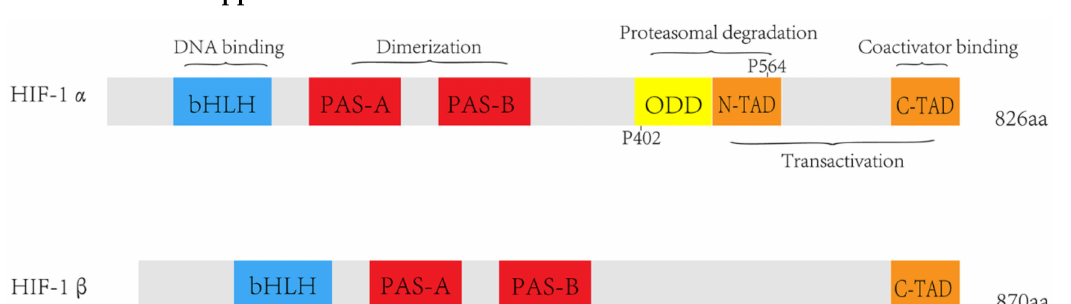
Figure A1. HIF-1 is a heterodimeric complex consisting of an HIF-1 α subunit and an HIF-1 β subunit. HIF-1 α contains multiple functional structural domains, including the bHLH structural domain, the PAS structural domain, the ODD structural domain, and the TAD structural domain. The bHLH and PAS domains are involved in dimerization and DNA binding, while the ODD domain is mainly involved in the proteasomal degradation of HIF-1 α under normoxic conditions, and the TAD domain is involved in the regulation of target genes by HIF-1 α . Abbreviations: bHLH: basic helix − loop − helix; PAS: Per-ARNT-Sim; TAD: trans-activation structural domain; ODD: oxygen-dependent degradation structural domain.